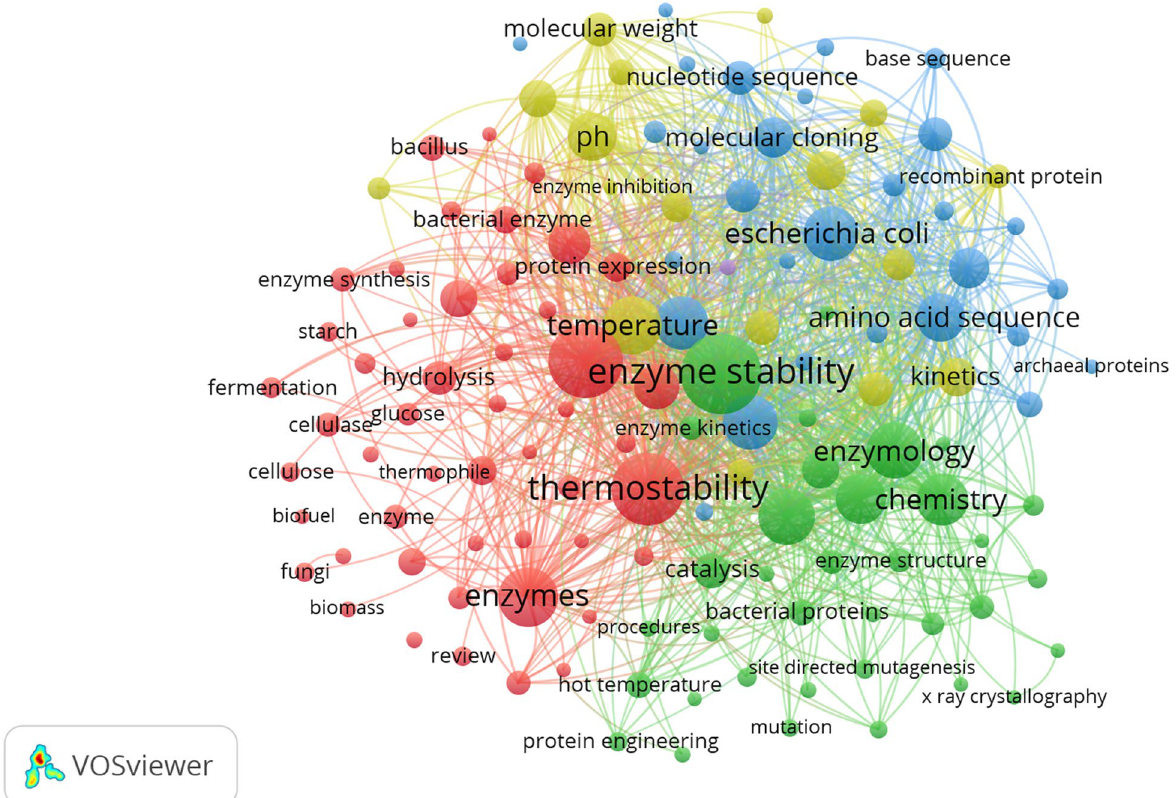
Fig. 7 Keyword trend analysis of scientific publications on thermostable enzymes in the Scopus collections database